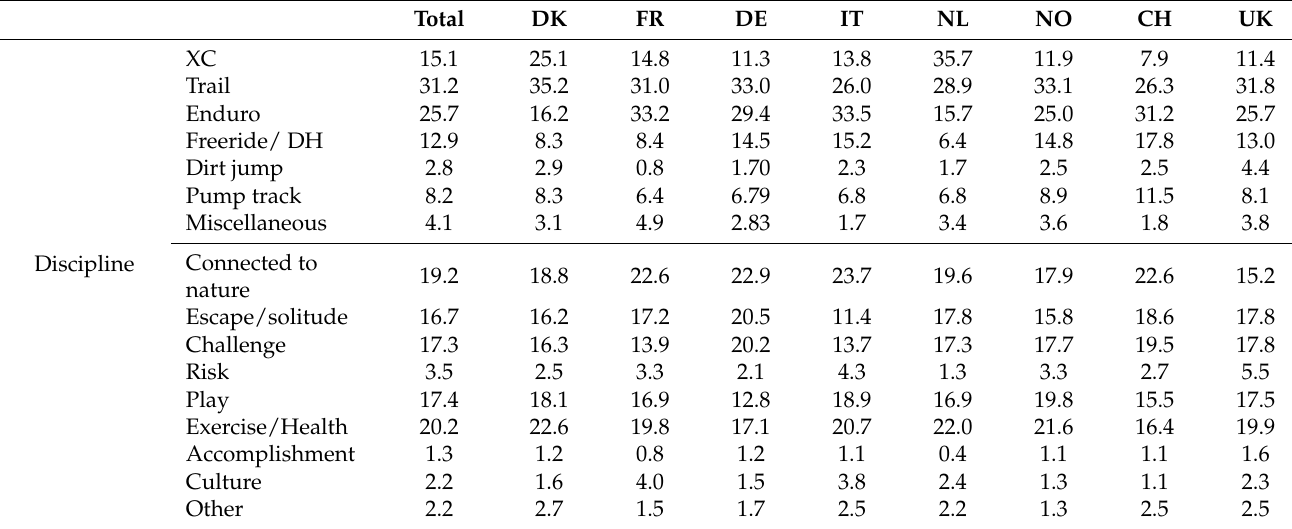
Table 3. Participation in mountain bike disciplines and the motivation for riding (n = 2050).